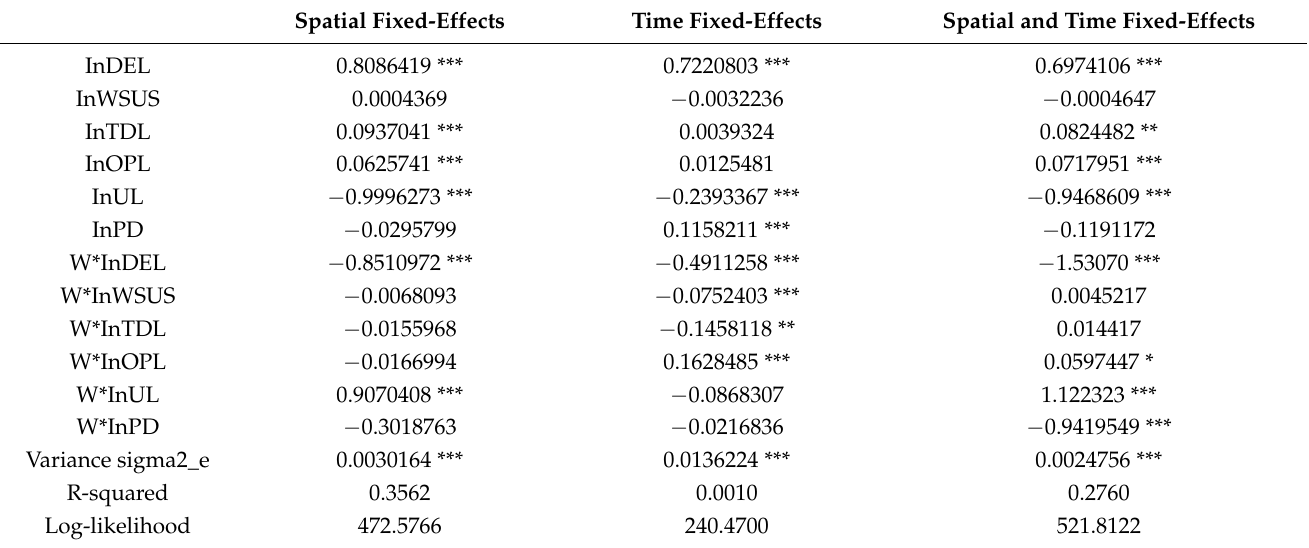
Table 7. The regression results of